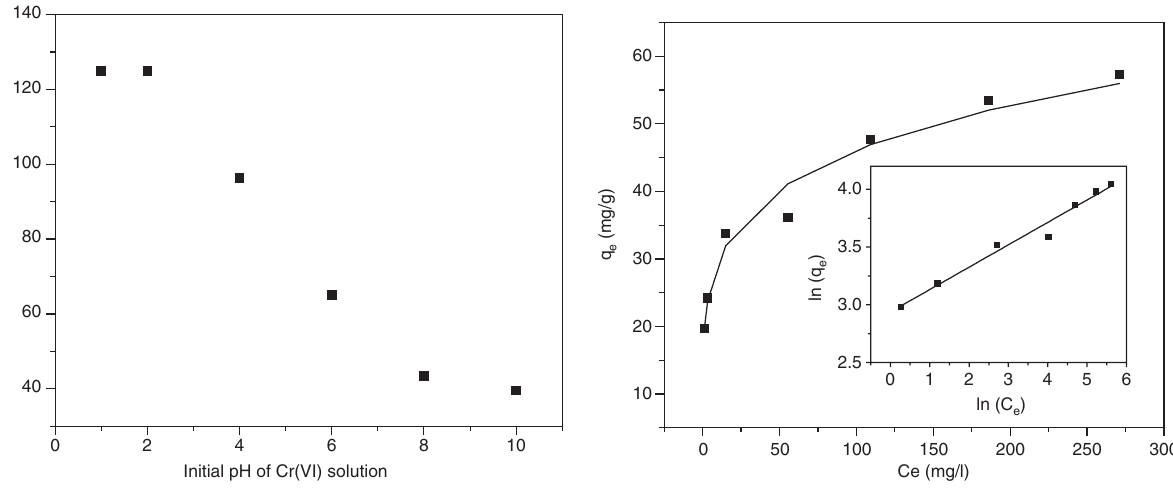
Figure 9 Equilibrium loading and linearized Freundlich isotherm for the adsorption of Cr(VI) on